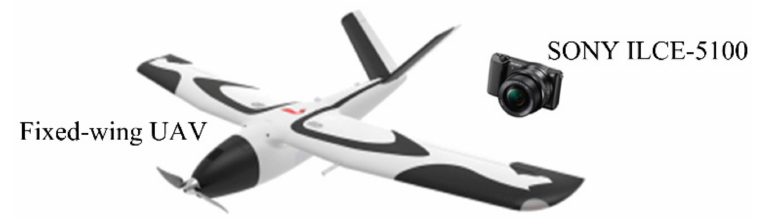
Figure 4. UAV platform and sensor for image